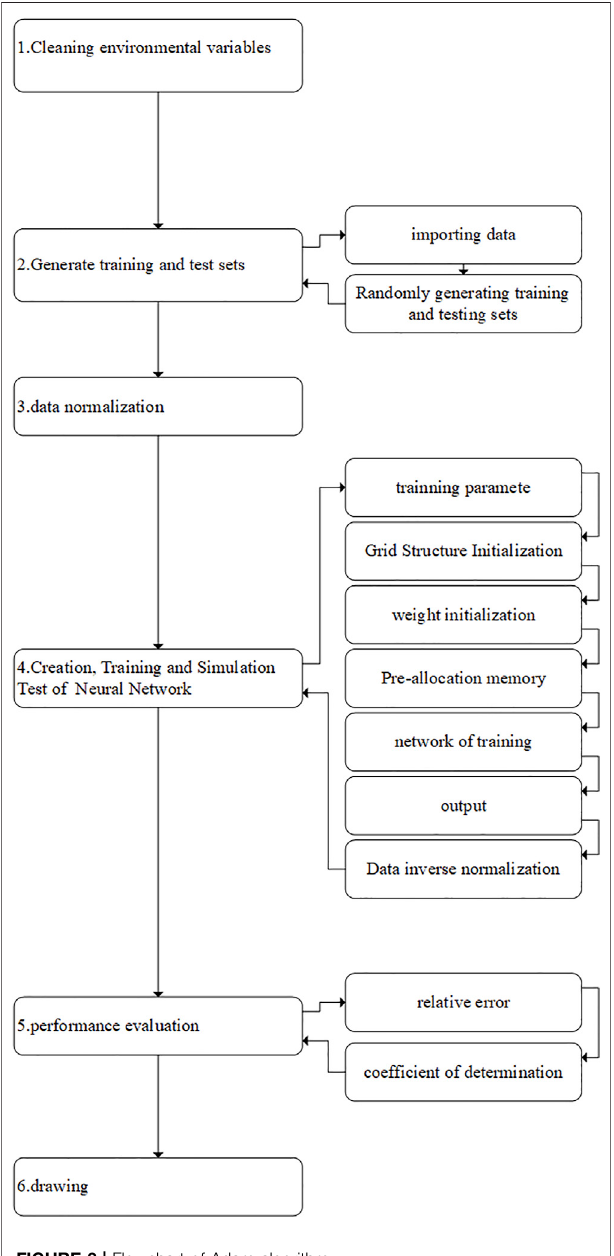
FIGURE 3 | Flowchart of Adam